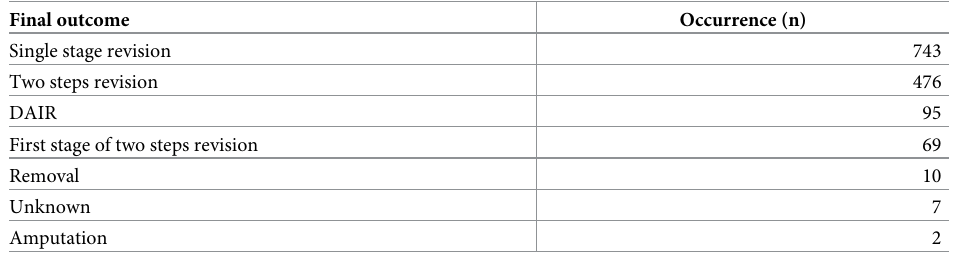
Table 6. Summary of final outcomes reported following